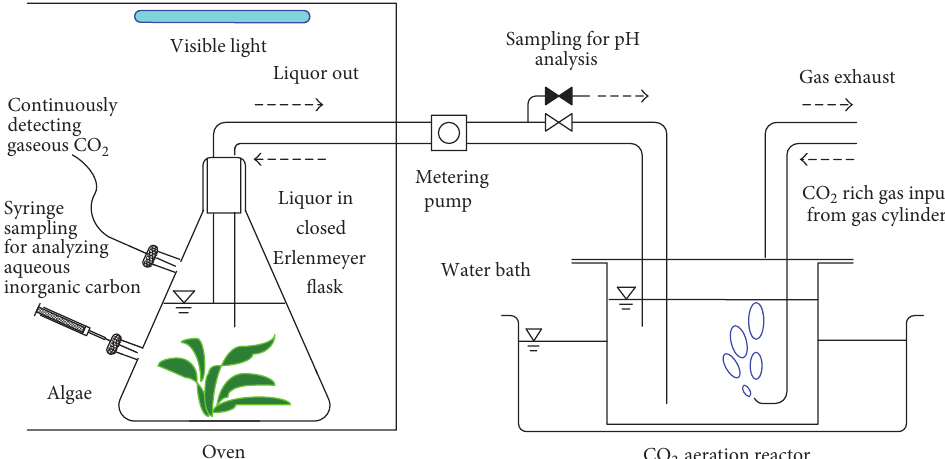
Figure 1: Experimental setup for carbon dioxide gas/liquor partitioning equilibrium.